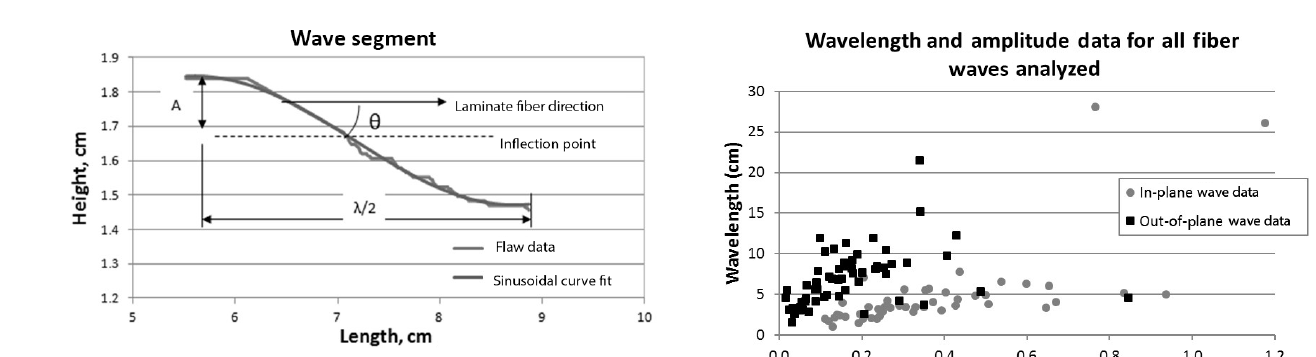
Figure 3. A sine wave superposed on a segment of the OP waviness shown in Fig. 2.